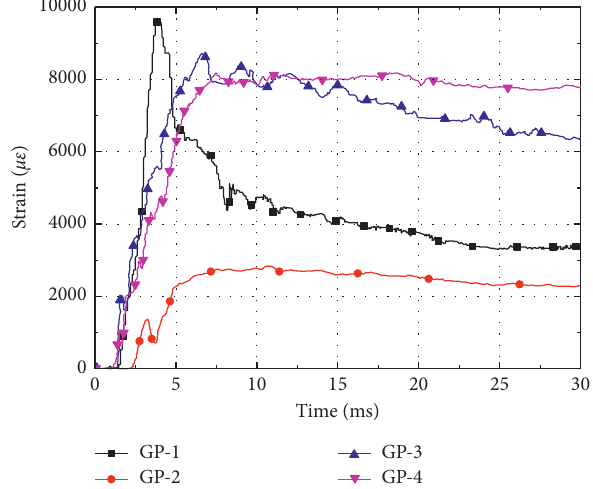
Figure 13: Strain time-history curve of ST1 collection